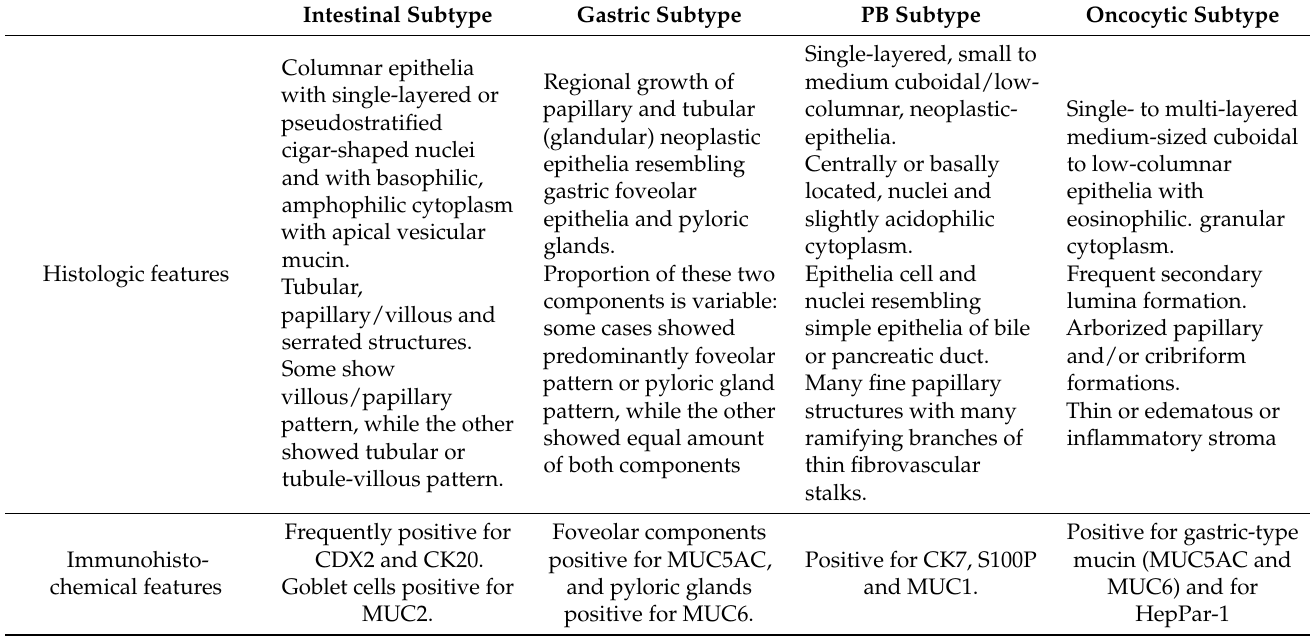
Table 1. Characteristic features of four subtypes in pancreatobiliary neoplasms based on cell